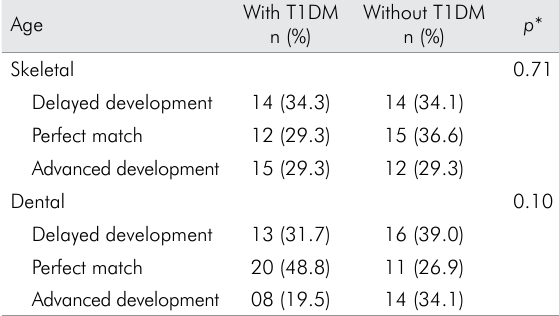
Table 1. Distribution of skeletal and dental ages of patients with and without T1DM in relation to chronological